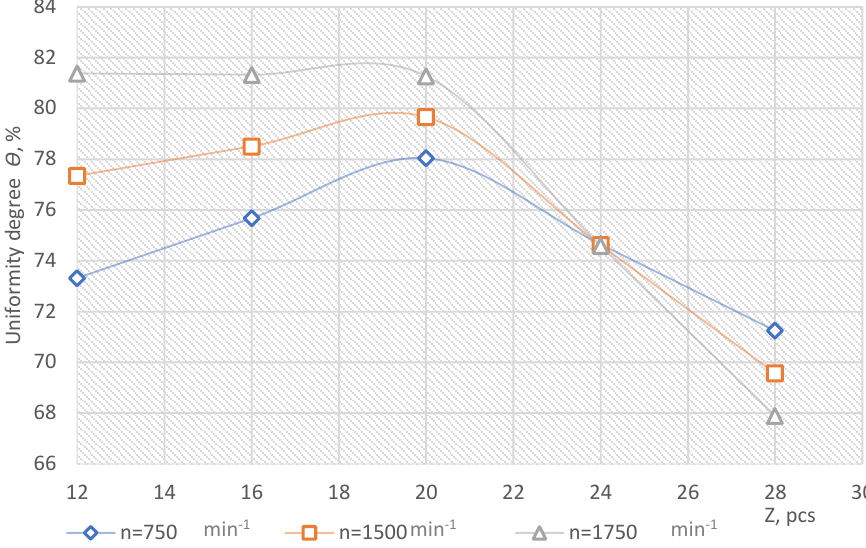
Figure 10. Dependence of the degree of homogeneity Θ ,% on the number of stationary blades Z, pcs, at different rotational speeds at angles β2 = 150 ° and βst = 150 ° .